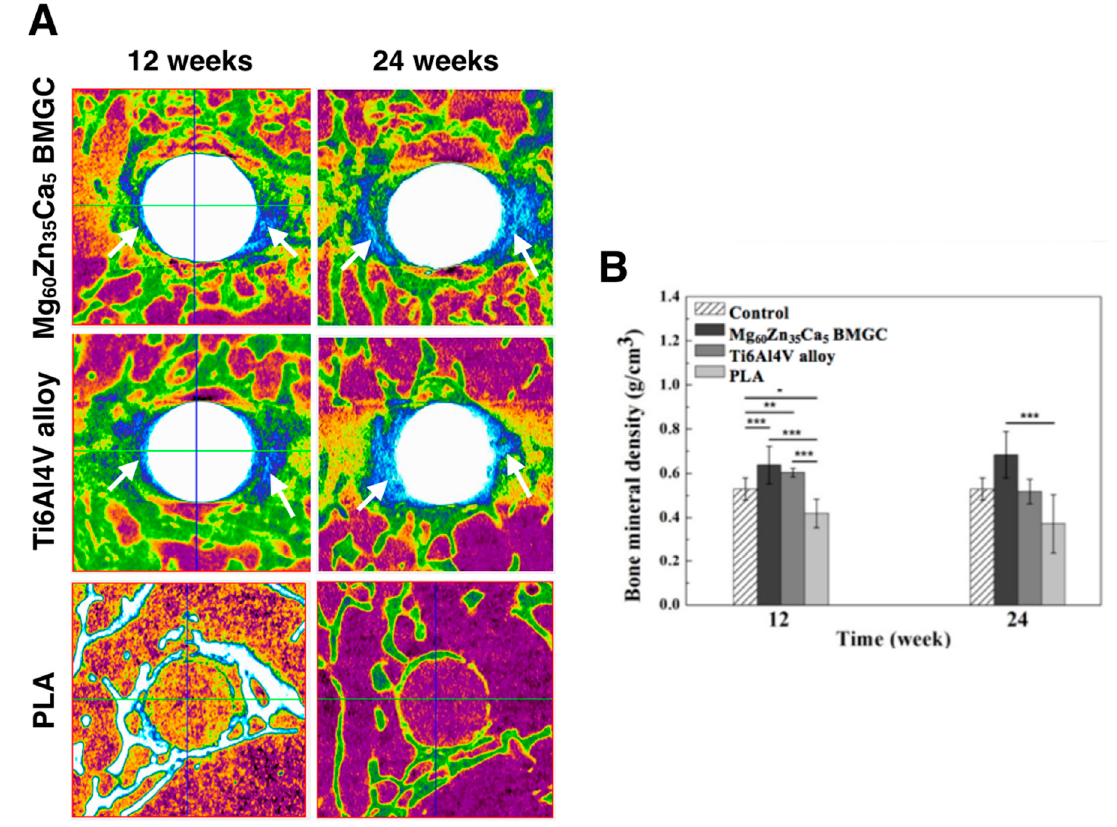
Figure 7. ( A ) Micro-CT image of the rabbit’s femur implanted with either Mg 60 Zn 35 Ca 5 BMGC, Ti6Al4V alloy, or PLA materials at 12 and 24 weeks postoperatively. ( B ) Intergroup comparison of bone mineral density surrounding the implanted site at 12 and 24 weeks, analyzed with CTan analyzer software (* p < 0.05, ** p < 0.01, *** p < 0.001).